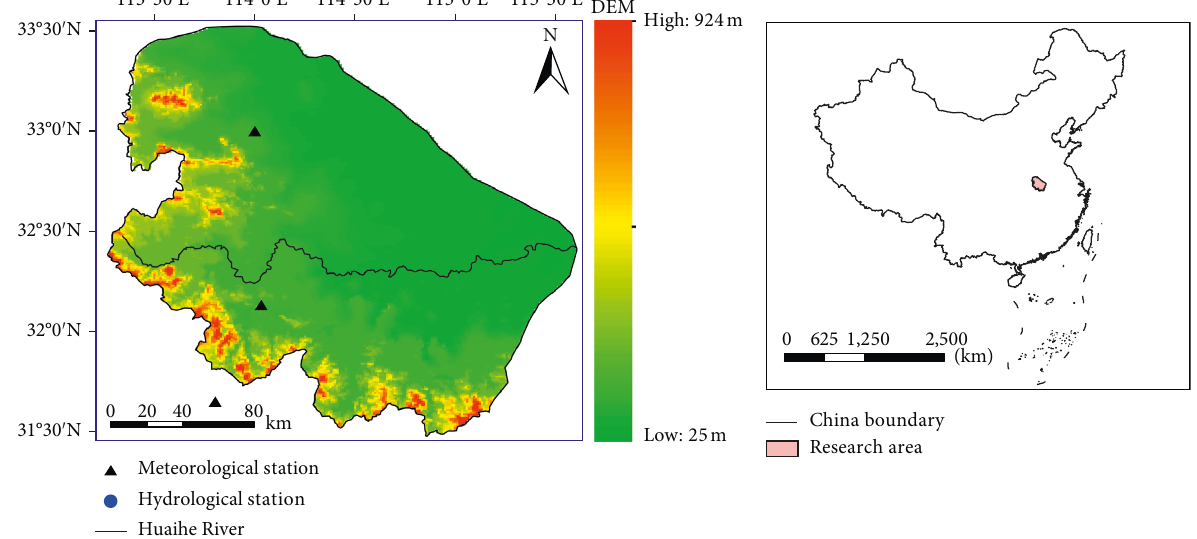
Figure 1: Distribution of the water system, meteorological stations, and hydrological stations in the upper reach of the Huaihe River Basin and its surrounding